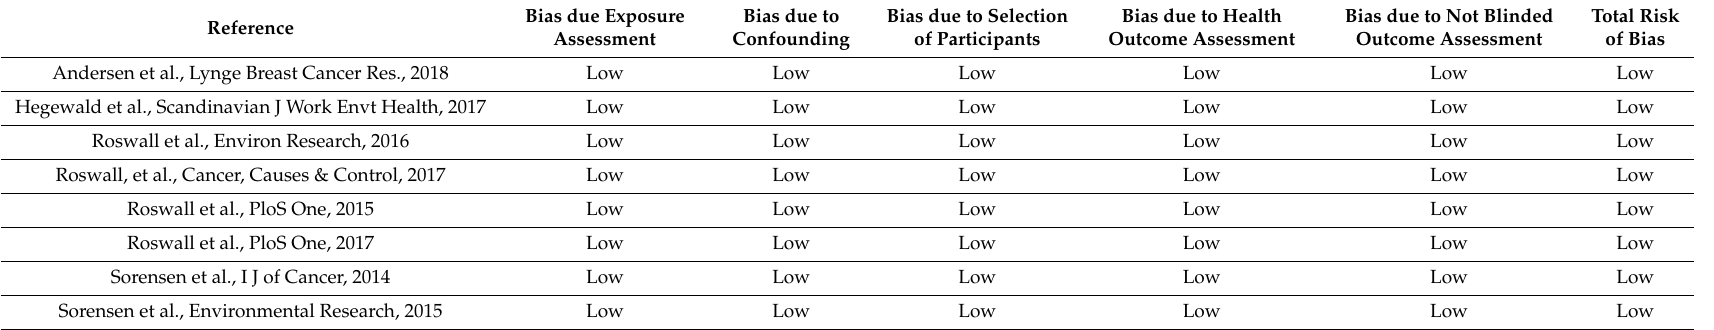
Table 3. Cancer: risk of bias.